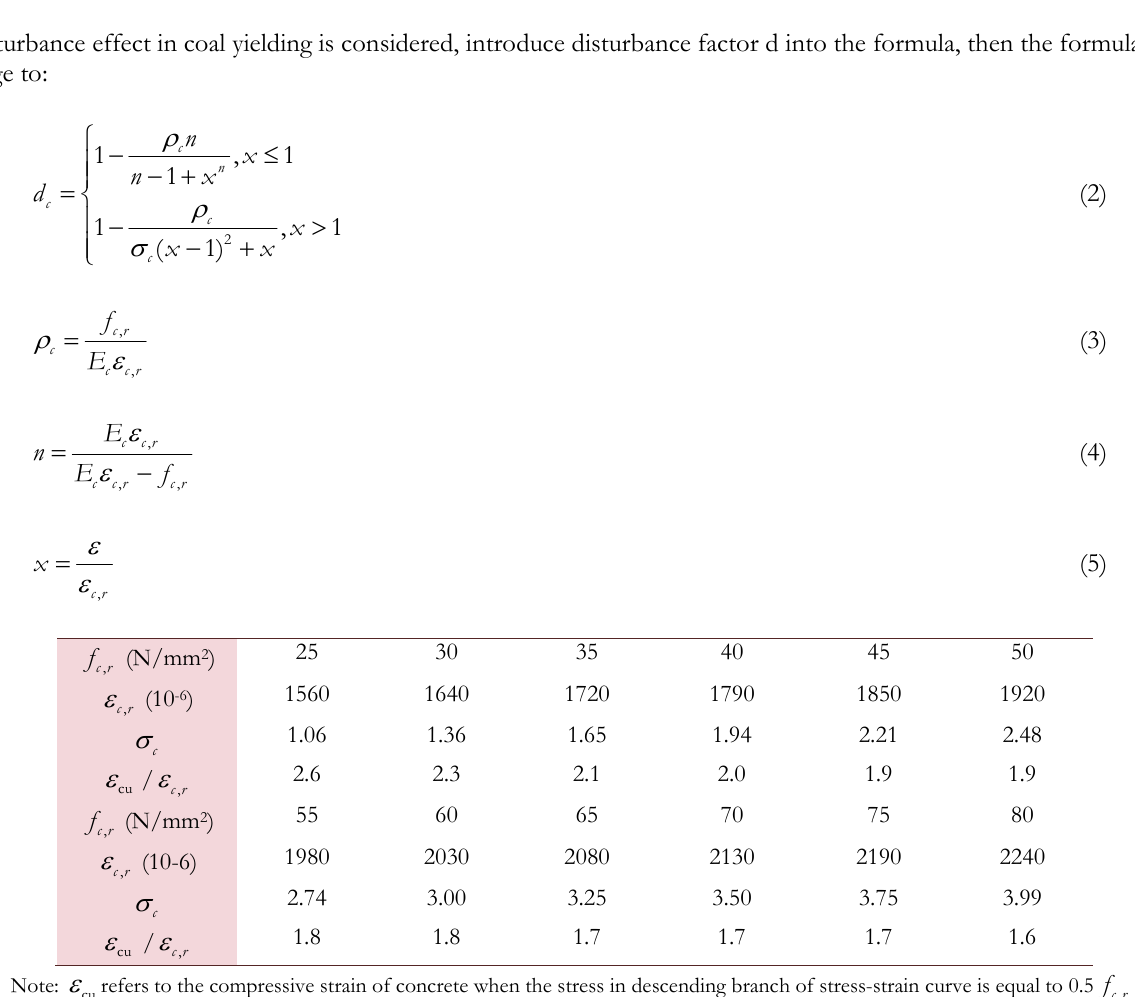
Table 1: Reference values of parameters relating to concrete single-axial compressive stress - strain